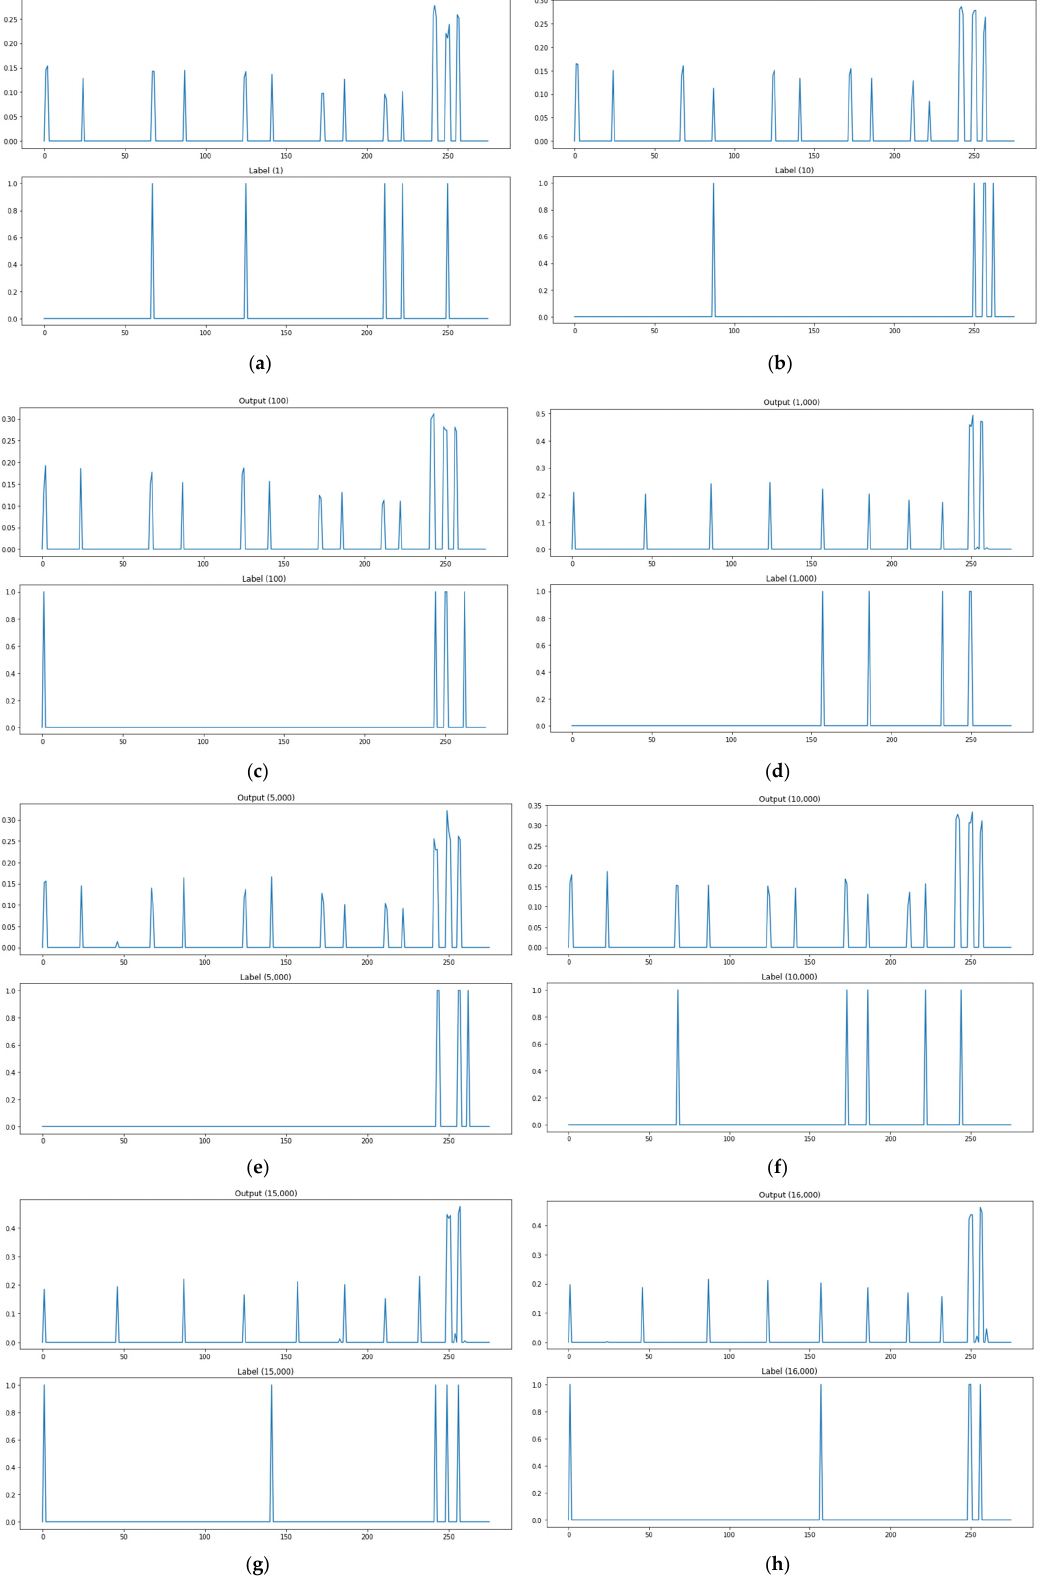
Figure 14. The outputs of the ANN and deep learning—output layer with ReLU (model 3). ( a ) Test data 1. ( b ) Test data 10. ( c ) Path test data 100. ( d ) Path test data 1000. ( e ) Path test data 5000. ( f )